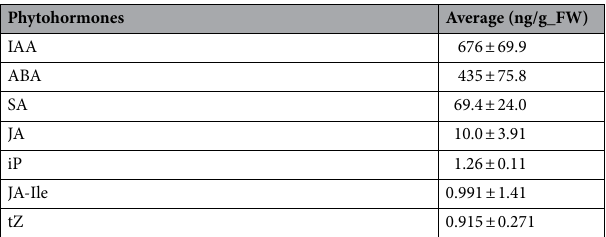
Table 1. The exogenous phytohormones contents in S.Chinensis . IAA, indole-3-acetic acid; ABA, abscisic acid; iP, isopentenyladenine; SA, salicylic acid; JA, jasmonic acid; JAIle, jasmonic acid-isoleucine; iP, isopentenyladenosine; tZ, trans-zeatin. Experiments were repeated at least three times using three biologically distinct samples. The results are given as mean ± standard deviation from four biological replicates (approximately 50–100 mg per